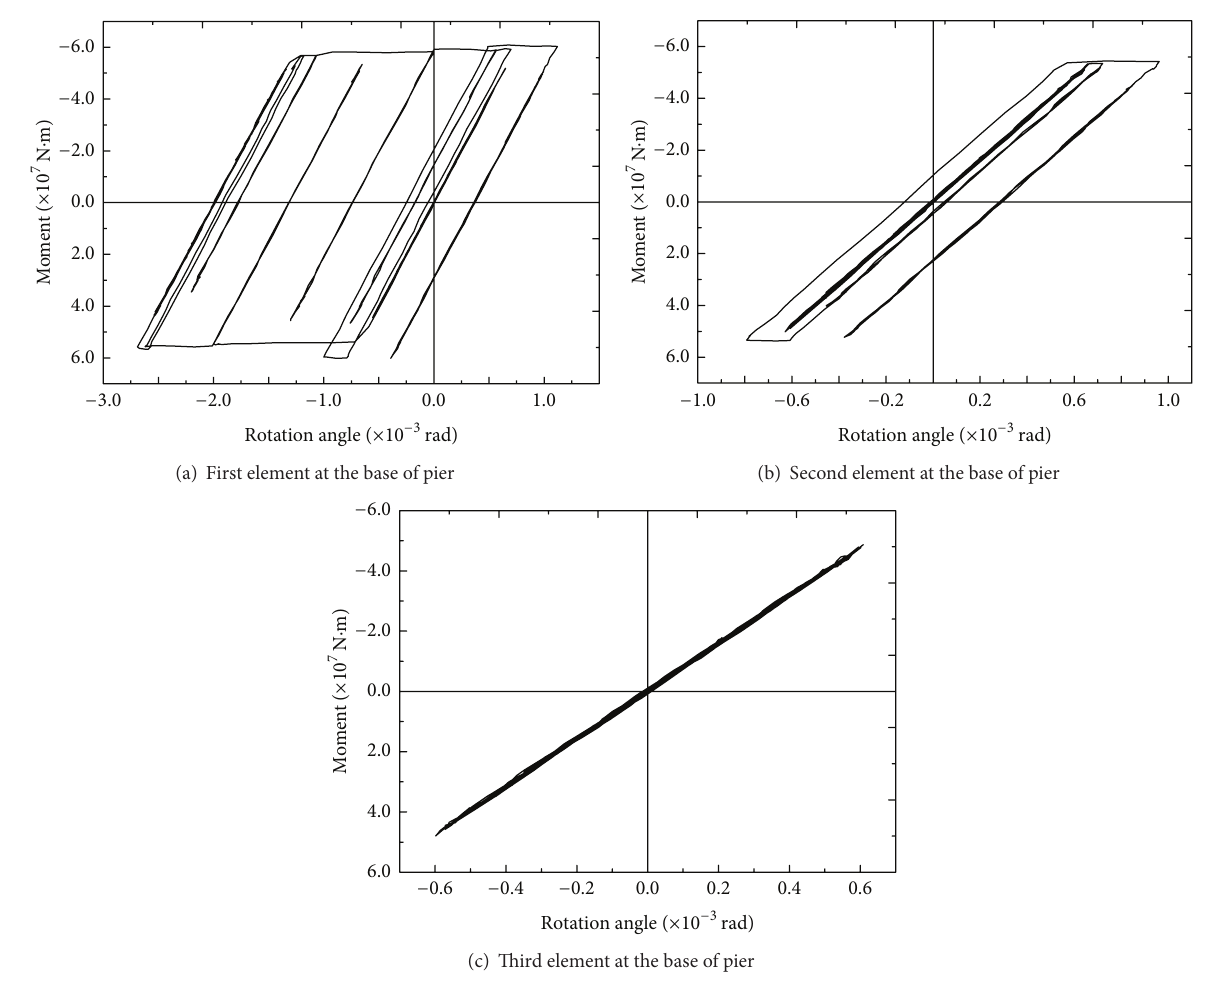
Figure 10: Moment-rotation relationship at the element of pier bottom for far-fault ground motion record of Tabas-FER-T1 with 350 km/h vehicle speed and 14m pier.